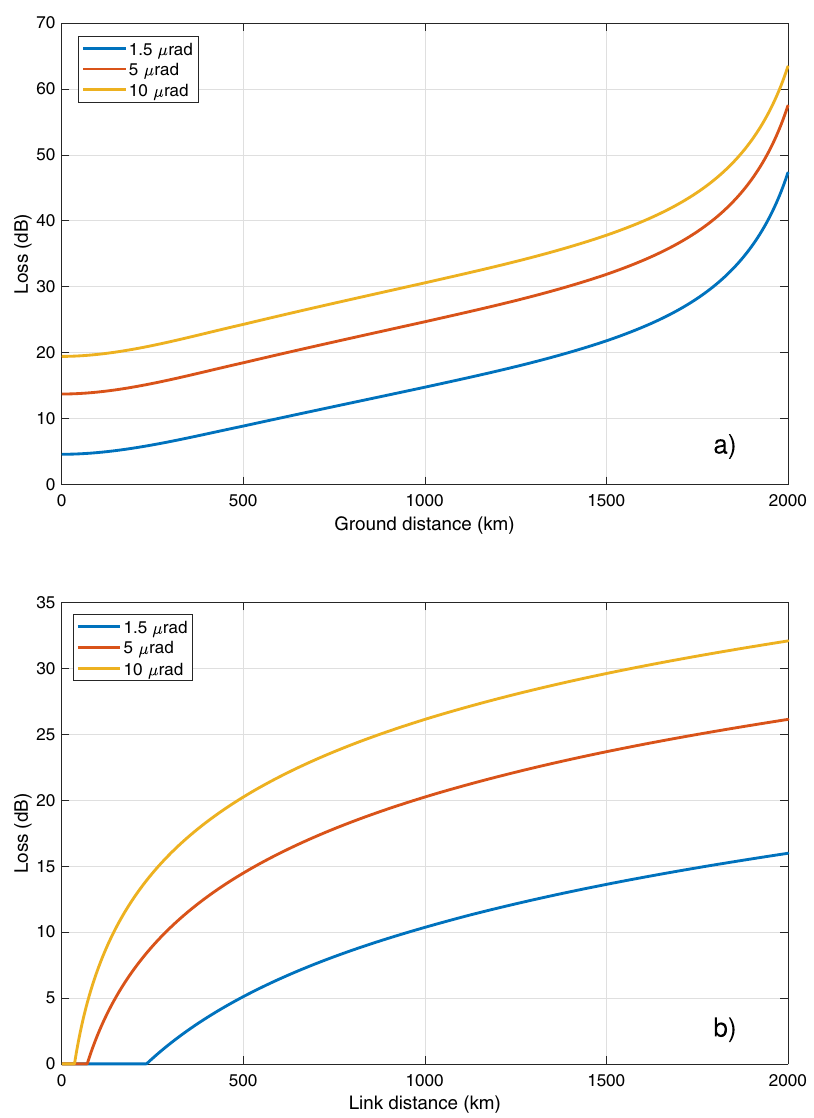
Fig. 6 Optical channel losses with different beam divergences. a Satellite-ground connection. b Satellite-satellite connection. Blue: 1.5 μ rad, red: 5 μ rad and yellow: 10 μ rad beam divergence,